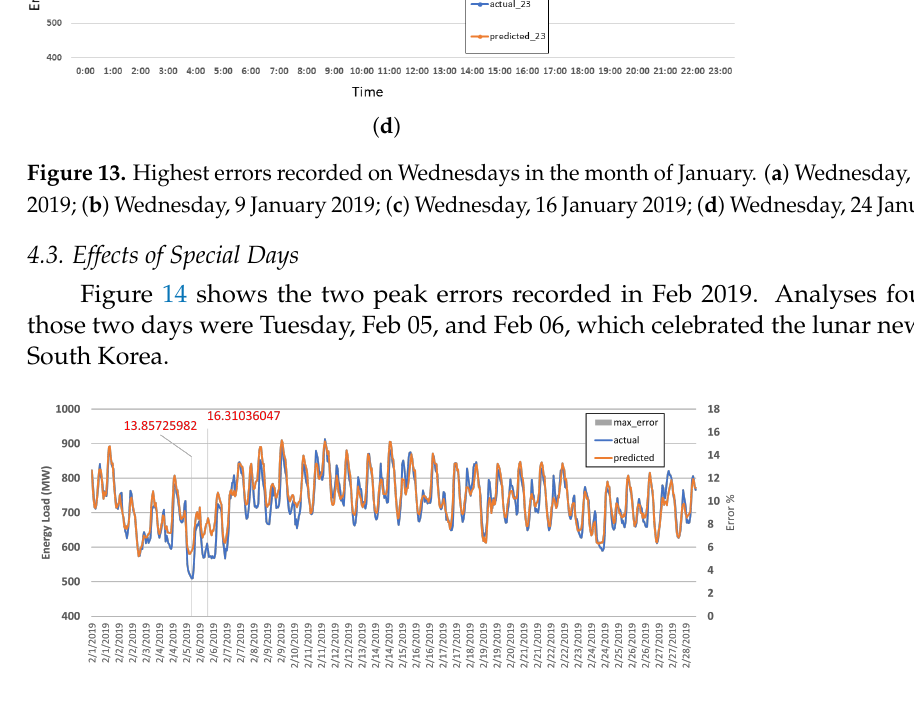
Figure 14. Peak errors recorded in the month of February 2019.